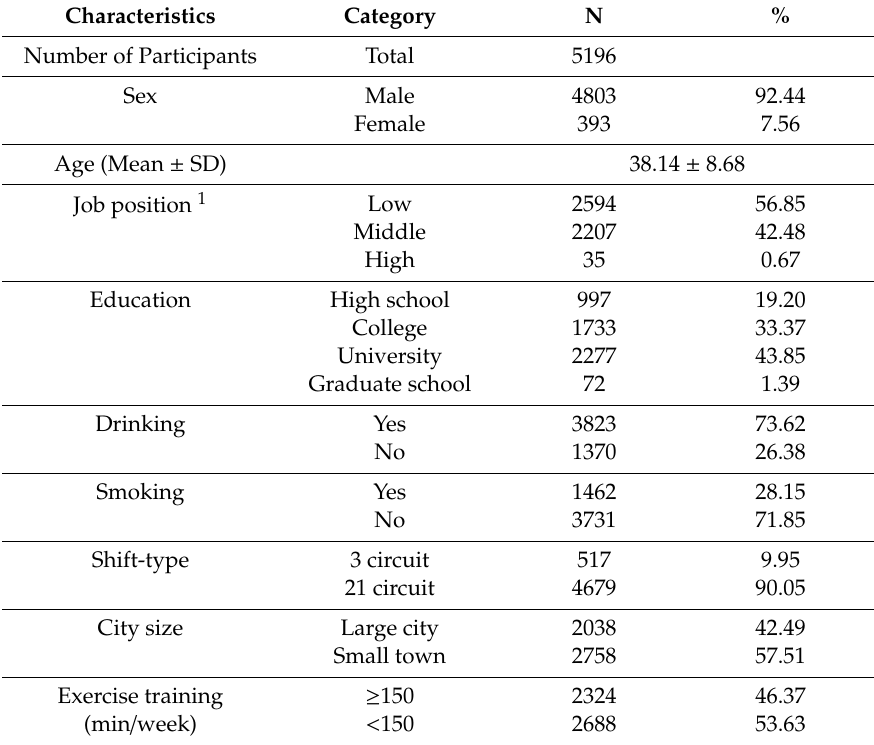
Table 1. Characteristics of